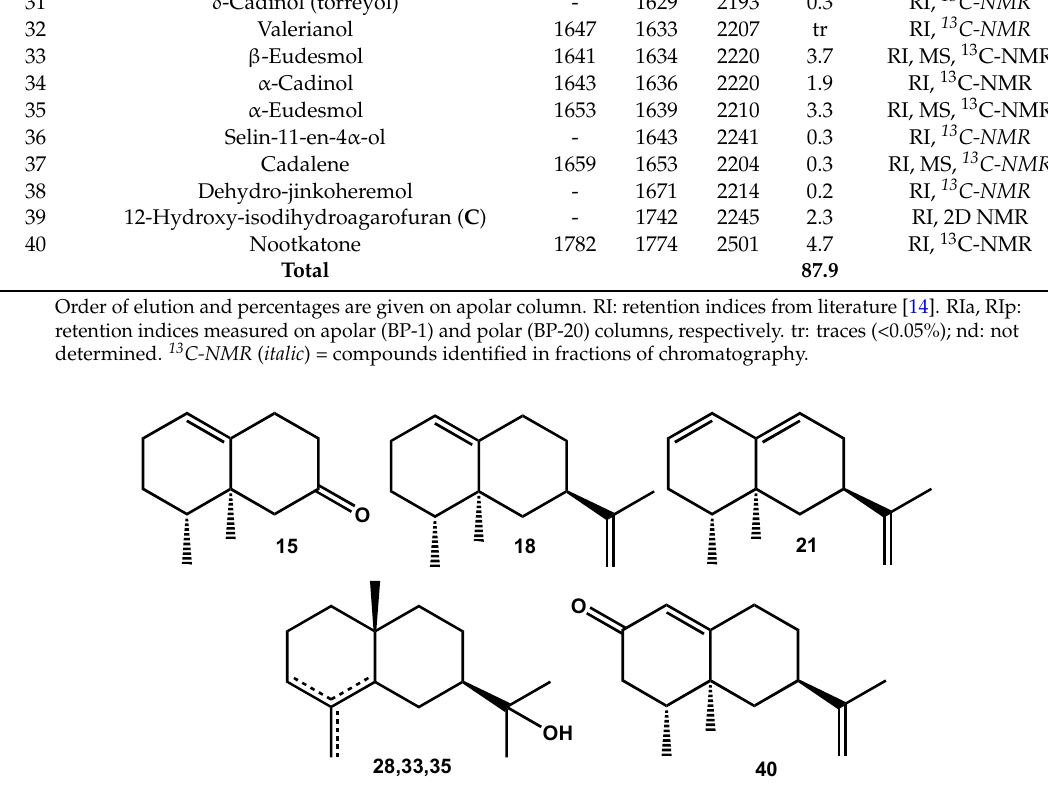
Figure 2. Major components of X. vietnamensis wood oil: 15 = 11,12,13-tri-nor-Eremophil-1(10)-en-7-one; 18 = Valencene; 21 = Nootkatene; 28 = γ -Eudesmol; 33 = β -Eudesmol; 35 = α -Eudesmol; 40 = Nootkatone.